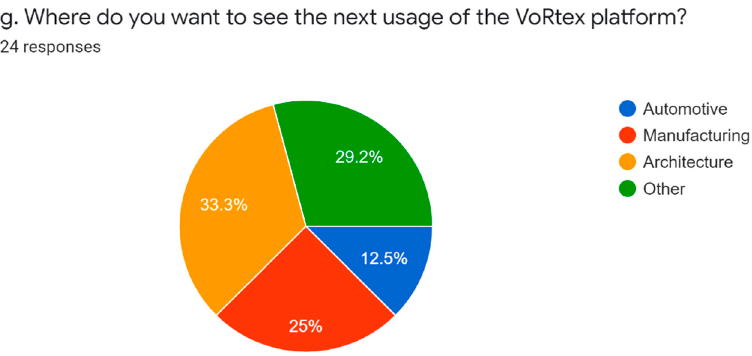
Figure 17. VoRtex test results from Google Forms report. Problem-solving activities.